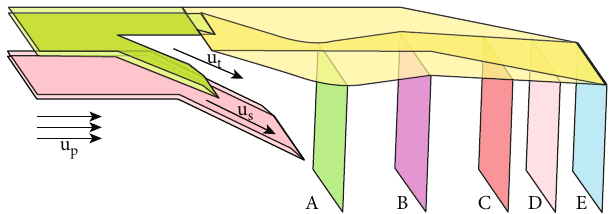
Figure 10: Positions of the monitoring surfaces for the vortexes. Table 3: Monitoring surface position parameters. Monitoring